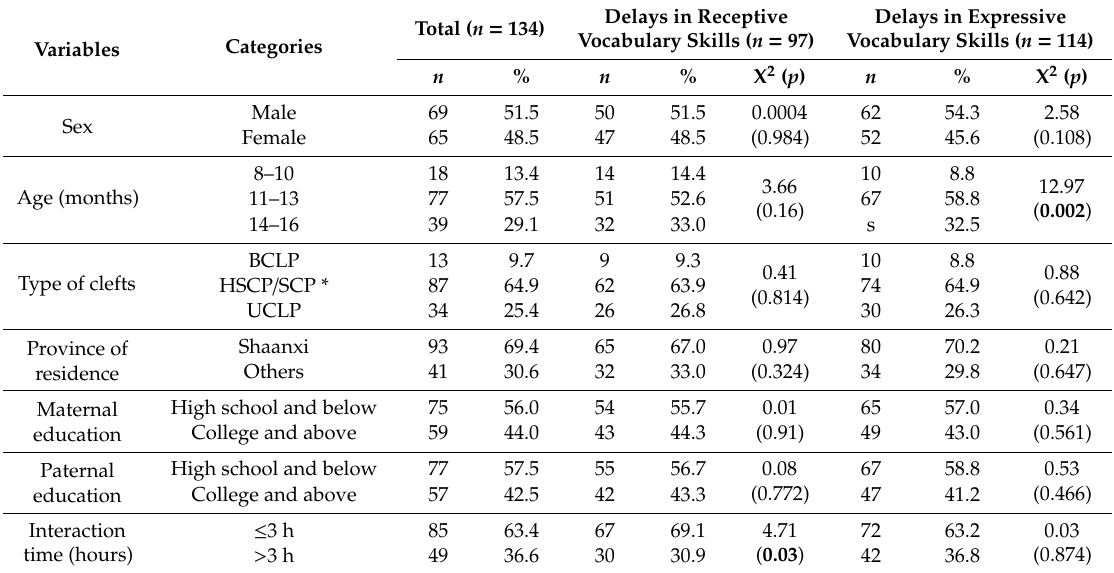
Table 1. Sociodemographic and clinical characteristics of the included